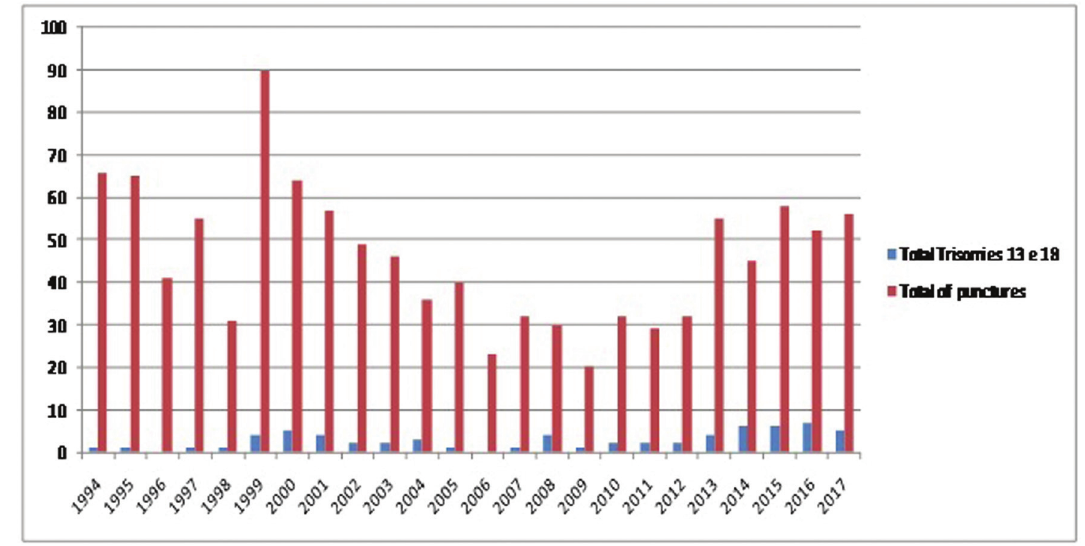
Figure 2 - Number of punctures vs. diagnoses of trisomy 13 or trisomy 18 during 23